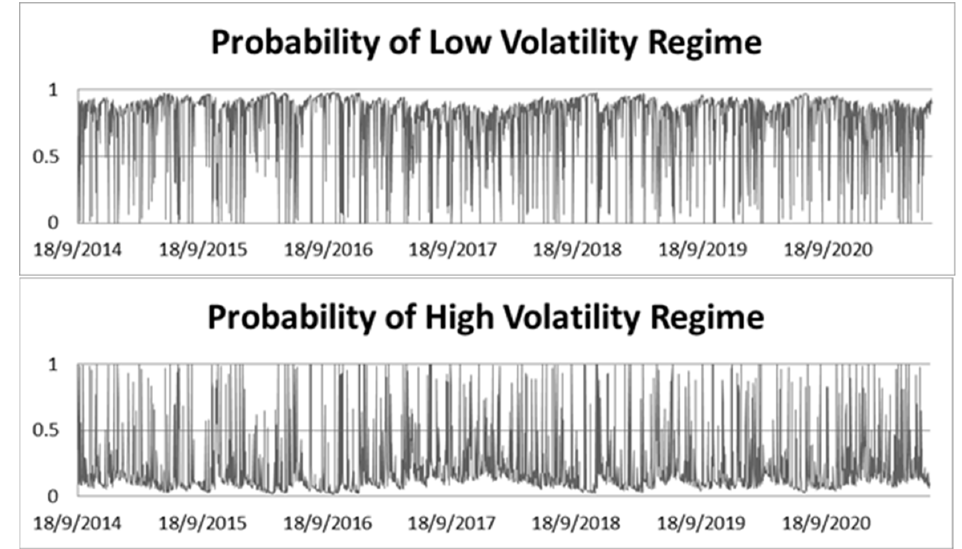
Figure 6. Smoothed Probabilities for two-regime GJR model.